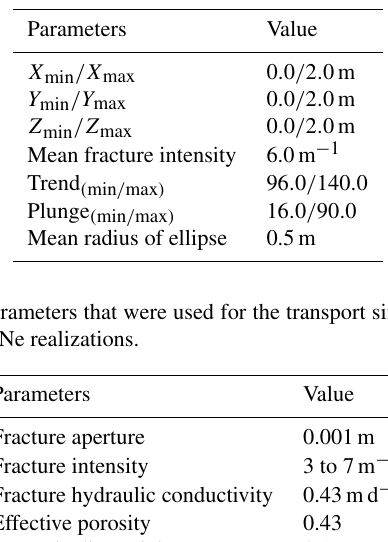
Table 2. Parameters that were used to generate 3-D DFNs for the flow example.